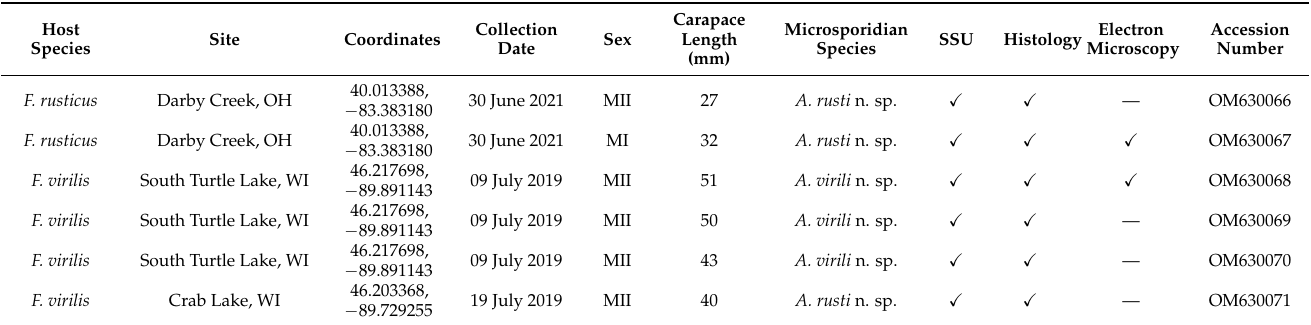
Table 1. Sampling detail of each individual crayfish collected with indication of what microsporidian species each crayfish was infected with and the data available for each